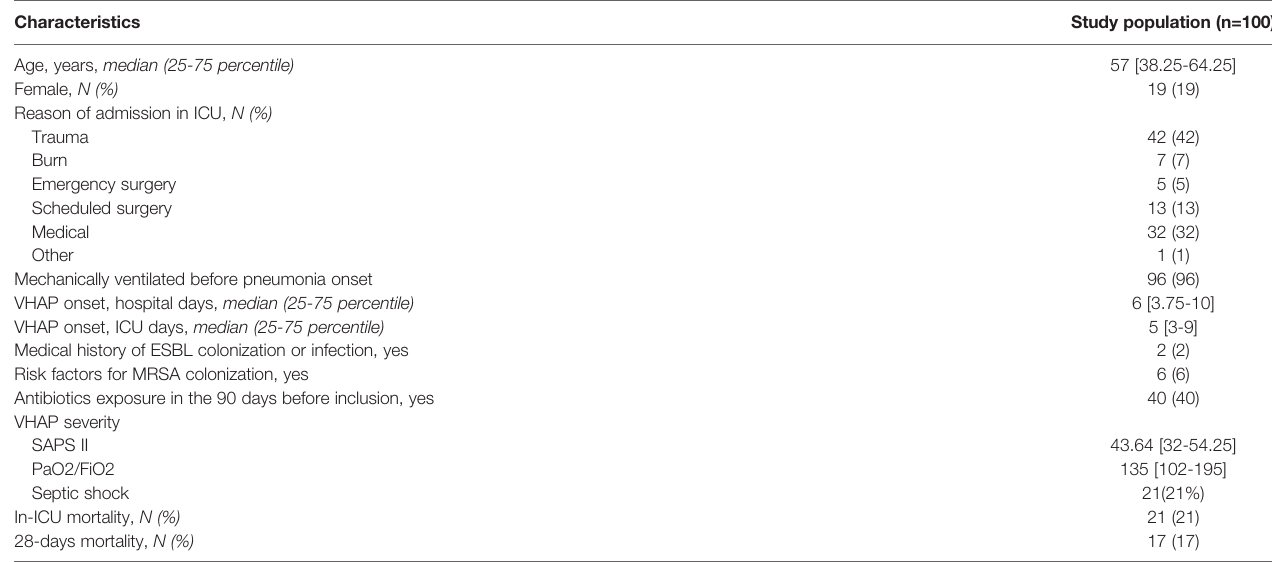
TABLE 1 | Population